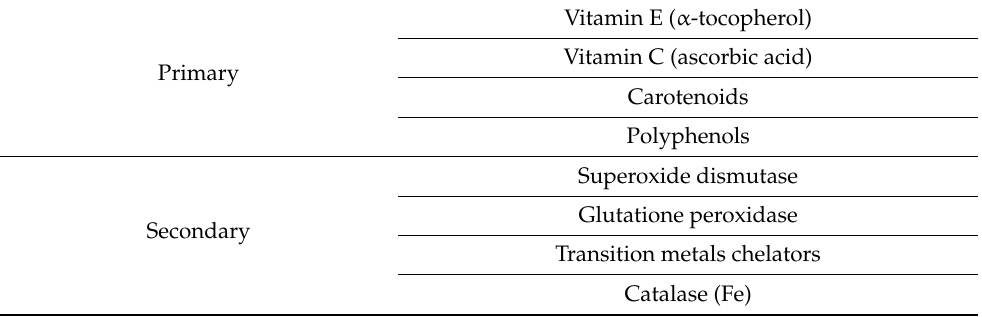
Table 4. Types of antioxidant defense in biological systems